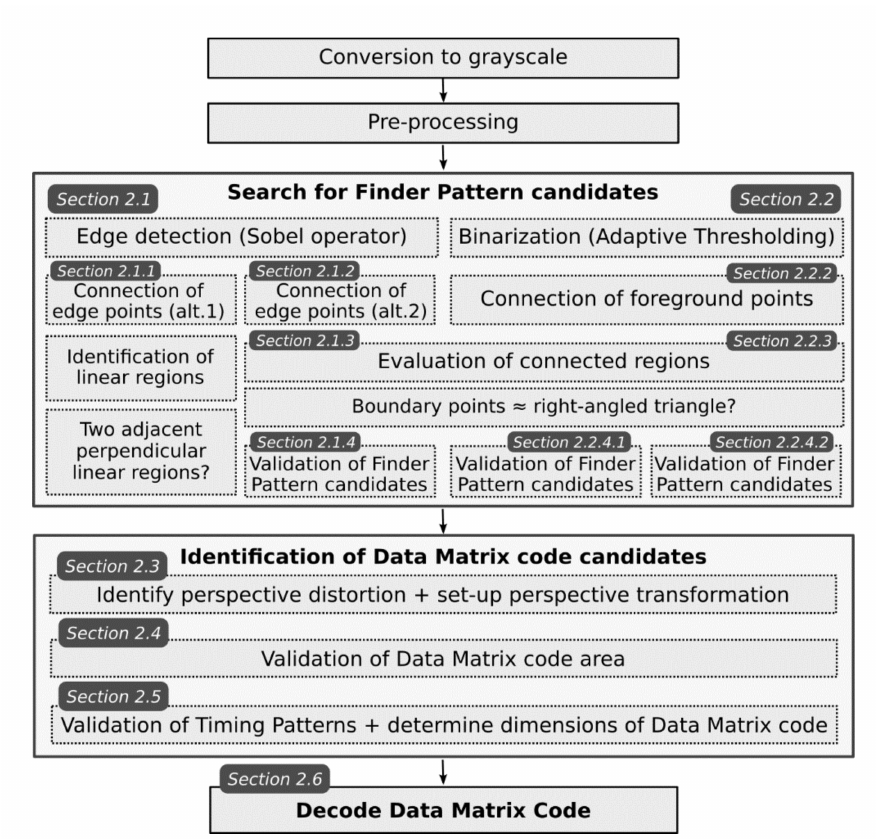
Figure 2. The flow chart of the proposed